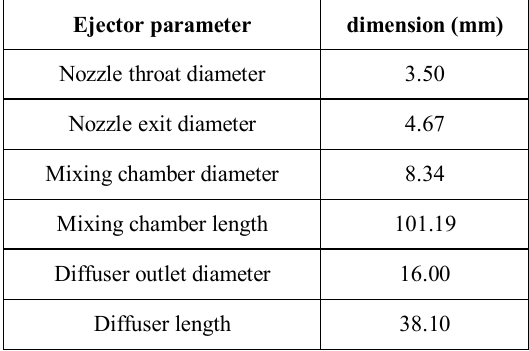
Table 1. Main geometry parameter of